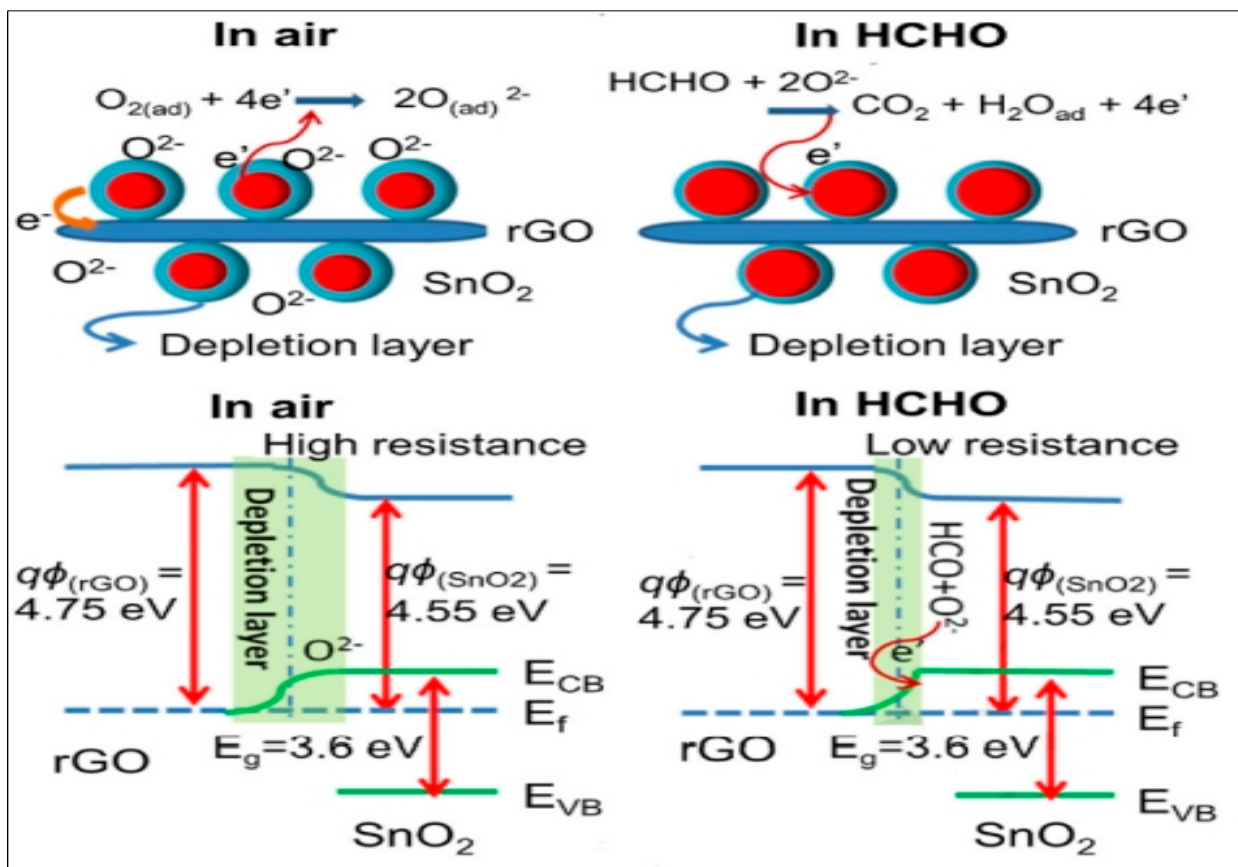
Figure 12. Graphical representation for sensing mechanism of rGO/SnO 2 sensor towards HCHO (Reprinted with permission from [167] Elsevier, License No. 5400000843096). (Reprinted with permission from [167] Elsevier, License No.